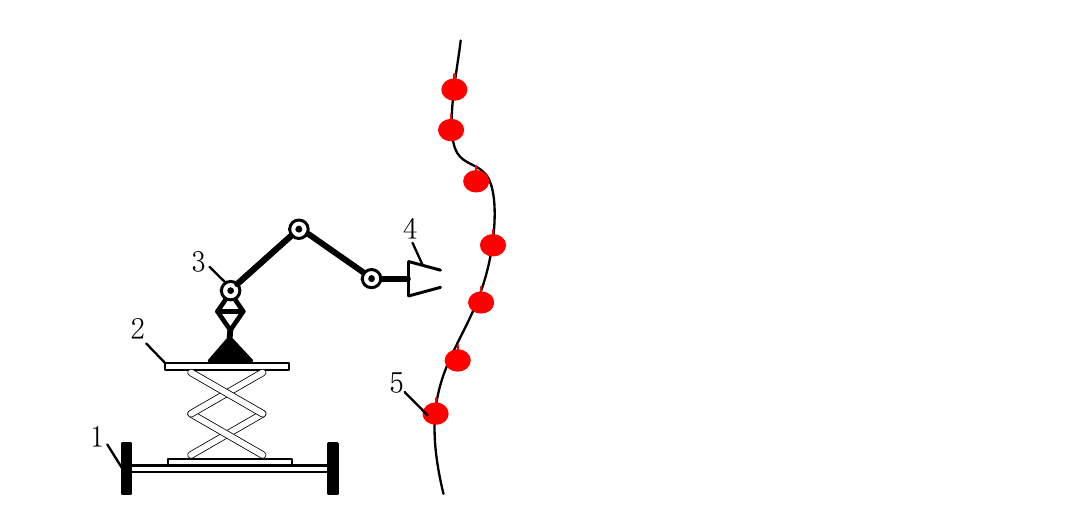
Figure 2. Tomato-picking robot. 1:chassis; 2: lift platform; 3: mechanical arm; 4: end-effector; 5: fruit.